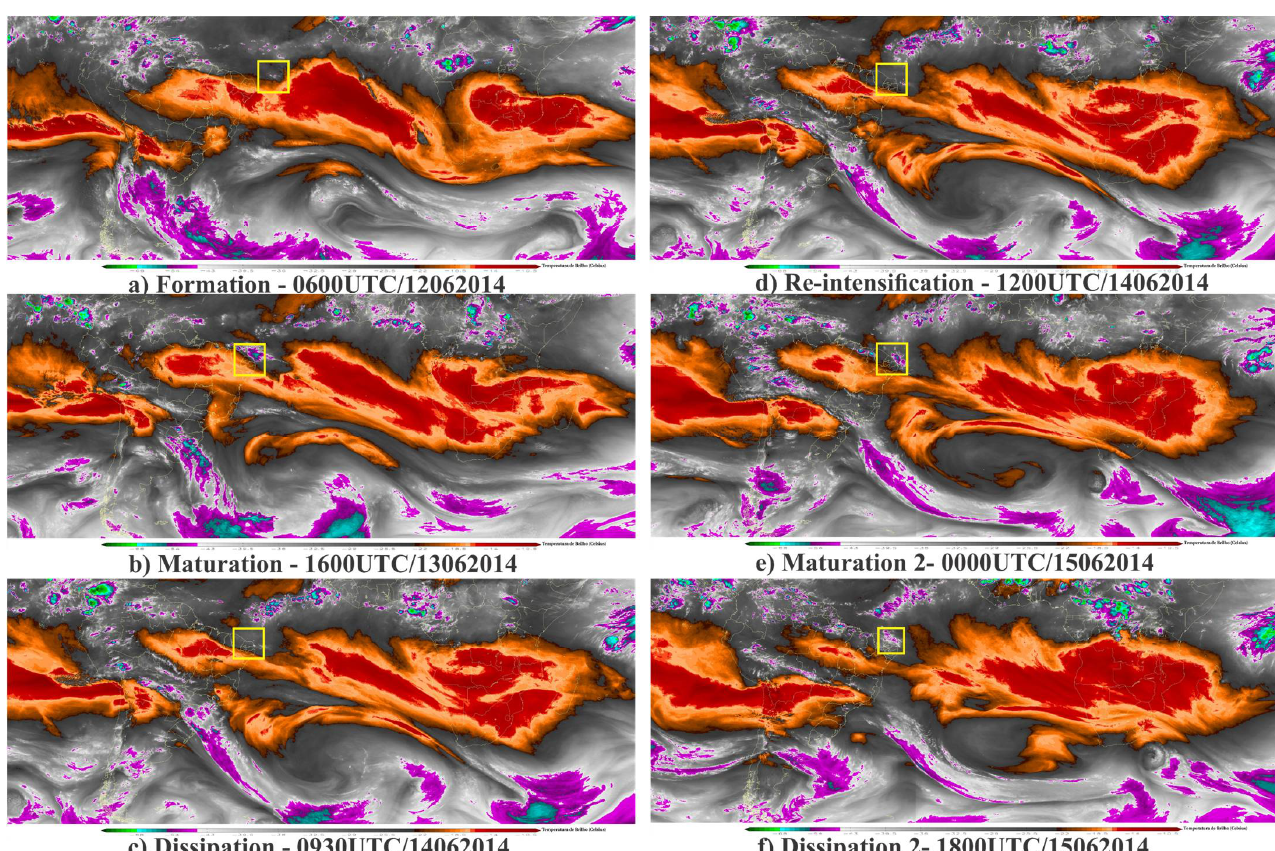
Figure 2. Satellite images showing the phases of ( a ) formation, ( b ) maturation, ( c ) dissipation, ( d ) re-intensification, ( e ) 2nd maturation and ( f ) 2nd dissipation. The yellow rectangle represents the identification of the evolution of the system.